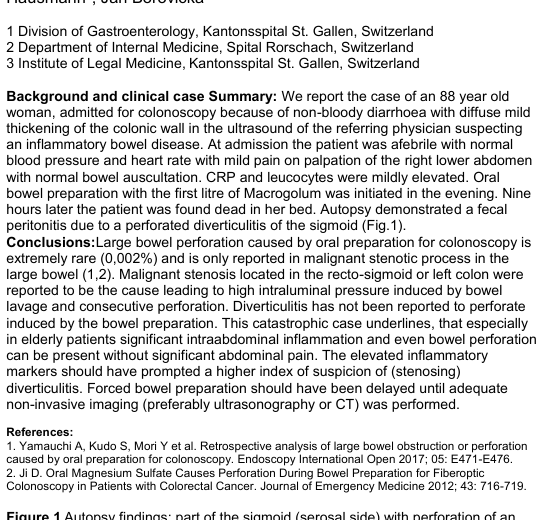
Figure 1 Autopsy findings: part of the sigmoid (serosal side) with perforation of an inflamed diverticulum